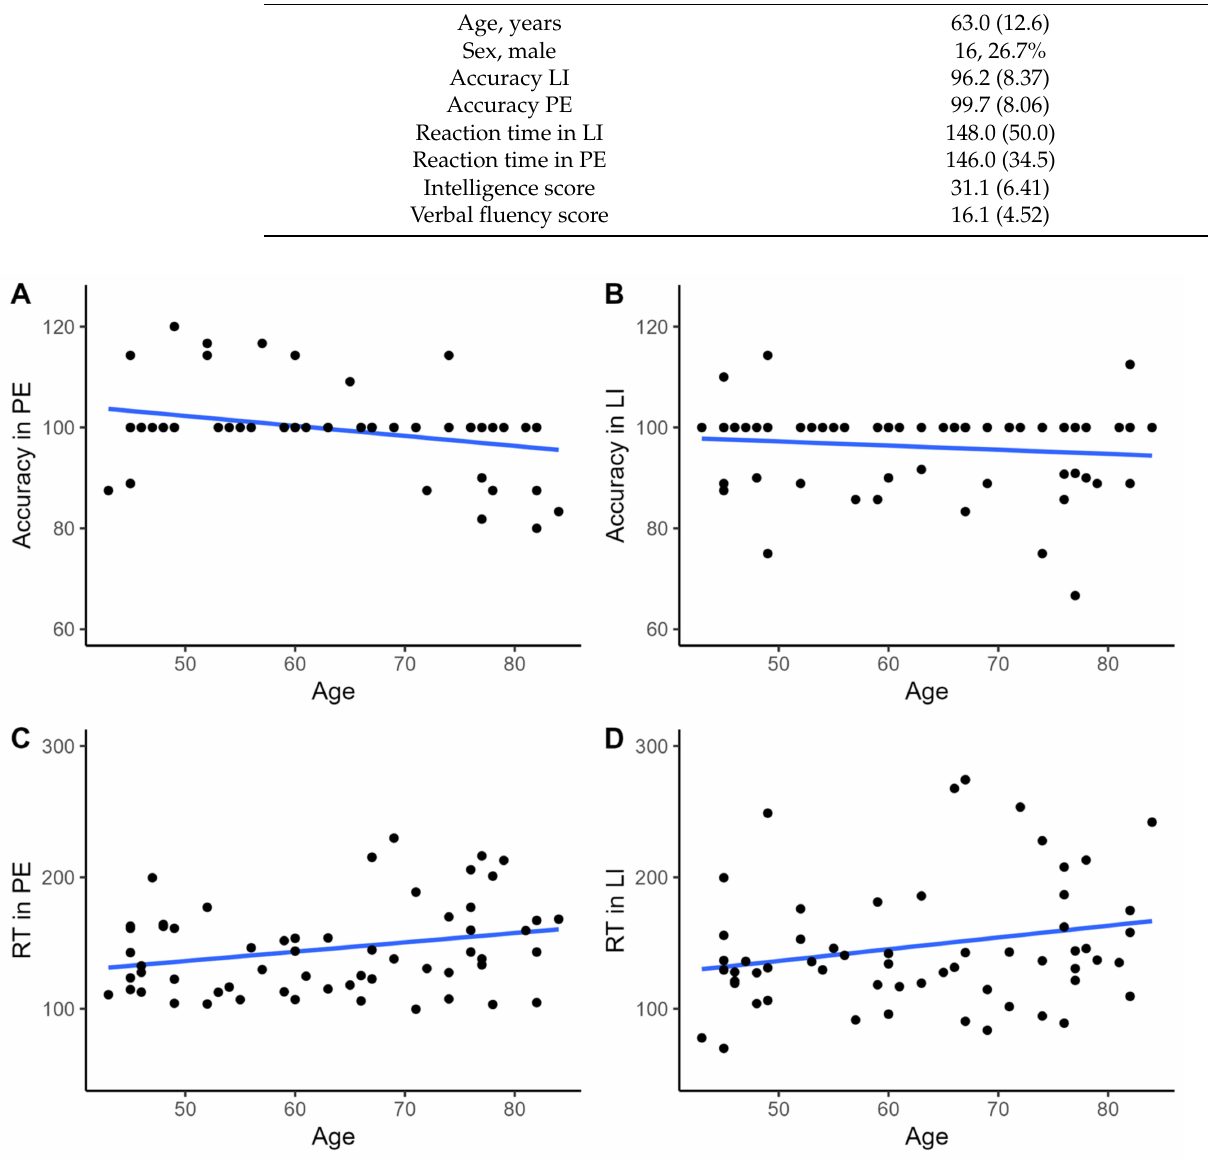
Table 1. Summary statistics for the total sample (N = 60).